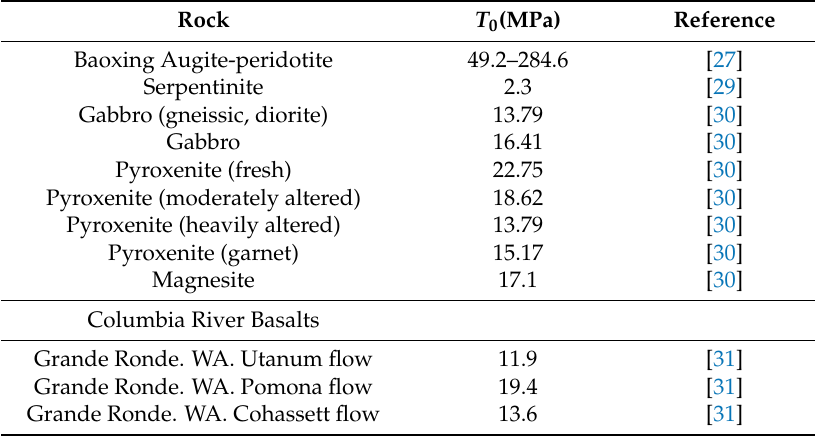
Table 1. Literature data on uniaxial tensile strength ( T 0 ) for peridotite, serpentinite, gabbro and Columbia River Basalts.